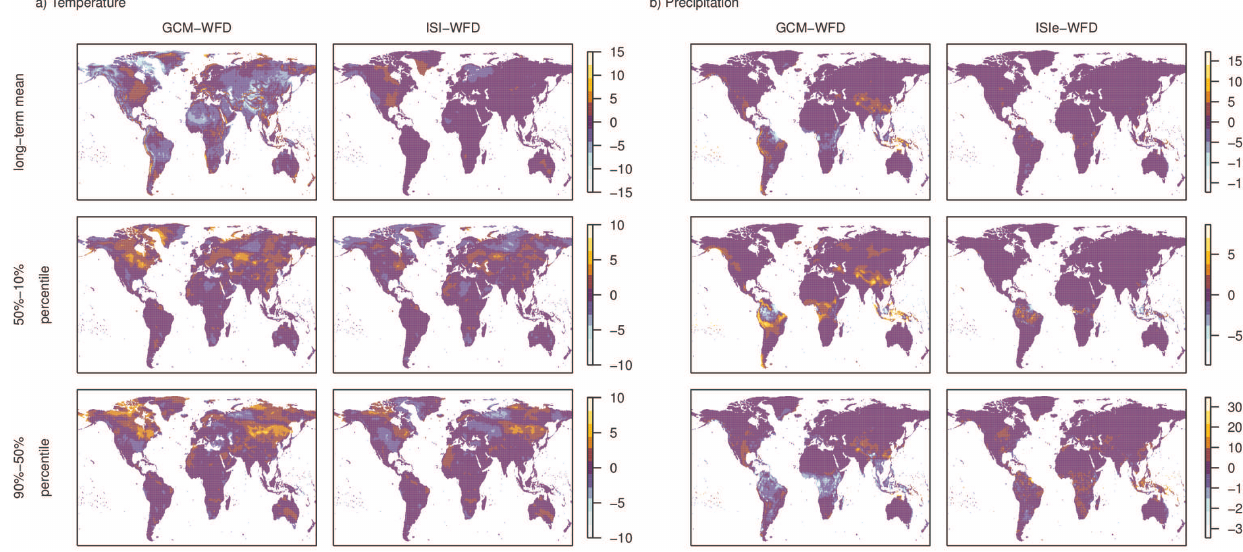
Fig. 7. The anomalies (i.e. simulation – observation) of statistical properties in raw (GCM) and bias-corrected (ISI and ISIe) model data are shown. The trend-preserving ISI-MIP methodology was applied to the period 1980 to 1999 for bias correction based on a 20yr reference period (1960 to 1979). In case of precipitation we present the results of the extended algorithm. The long-term mean, lower inter-percentile range and upper inter-percentile range of the April daily (a) temperature and (b) precipitation from 1980 to 1999 are shown. The 50–10% percentile refers to the lower inter-percentile range, while 90–50% percentile denotes the upper inter-percentile range. Colours refer to (a) temperature values in K and (b) precipitation values in mmday − 1